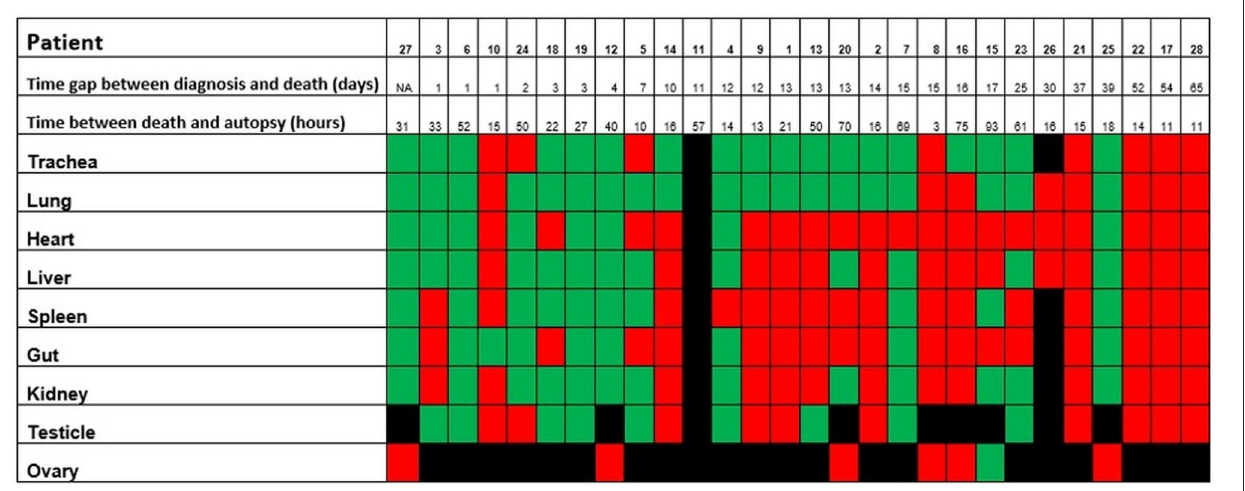
FIGURE 7 | Positivity of the postmortem swabs in the different organs (green: positive, red: negative, black: not available). The patients are ordered from left to right in a crescent pattern based on the number of days between diagnosis of COVID-19 through nasopharyngeal swab and death. Abbreviations: NA, not available.